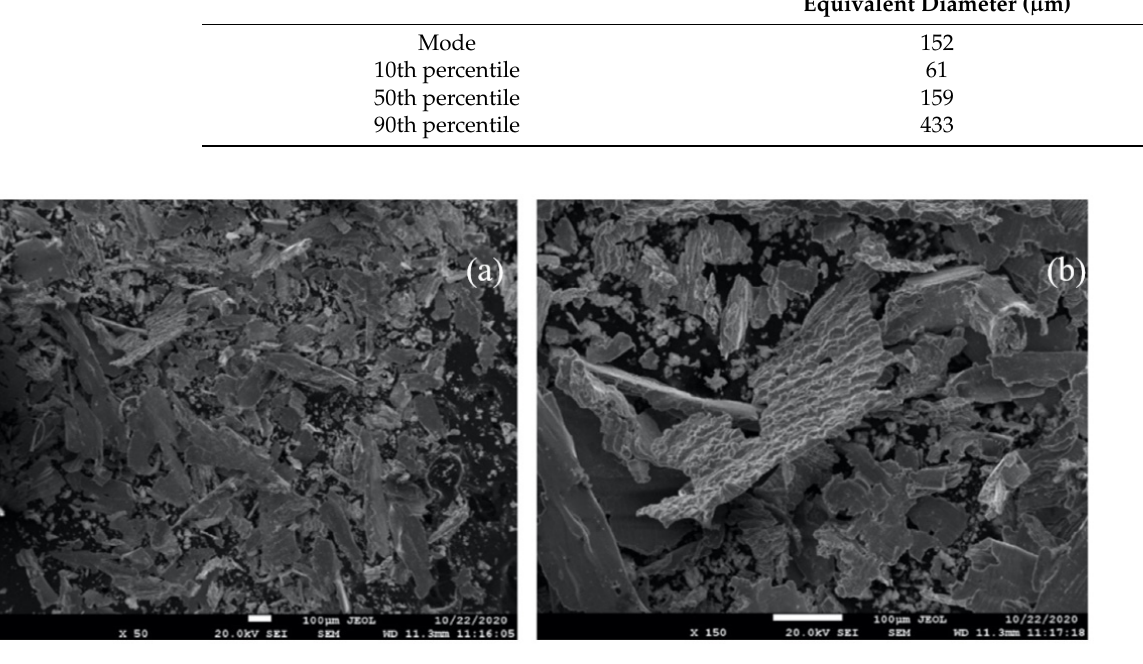
Figure 2. Scanning electron microscopy images under different magnifications; ( a ) ×50, ( b ) ×150.